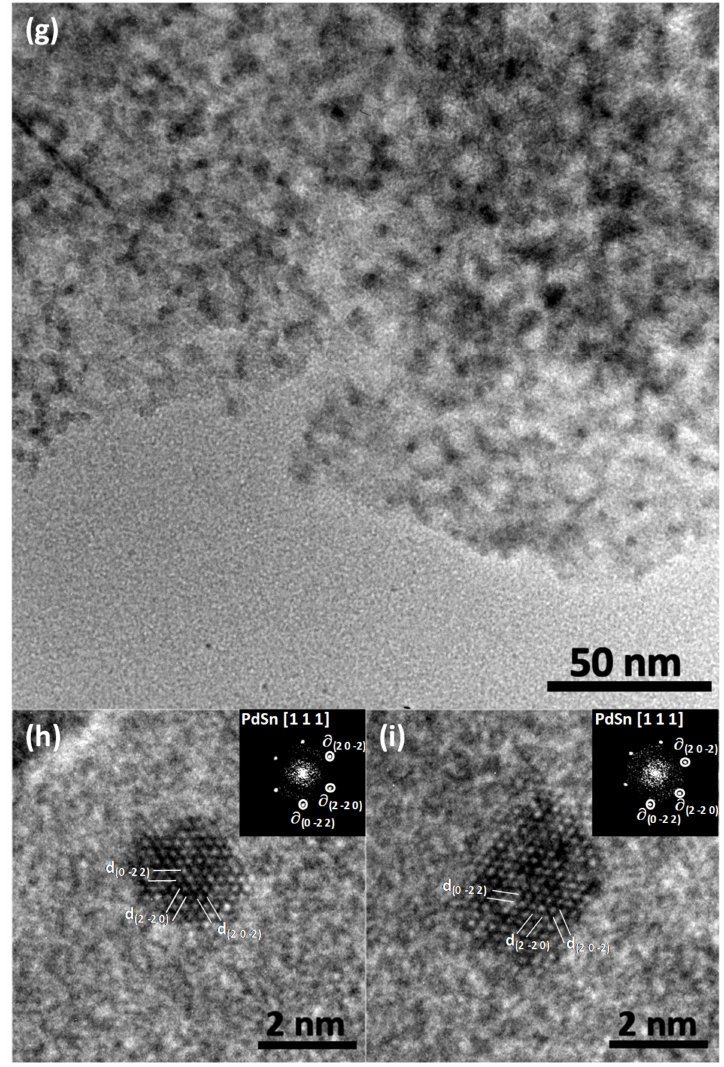
Figure 1. TEM ( a , d , g ) and HRTEM ( b , c , e , f , h , i ) images of the samples Pd/ γ -Al 2 O 3 ( a – c ); 3Pd1Sn/ γ - Al 2 O 3 ( d – f ) and 1Pd1Sn/ γ -Al 2 O 3 ( g – i ). Inserts in the HRTEM images correspond to the 2D-FFTs of the respective nanoparticles; in the inserts ∂ (hkl) correspond to 1/d (hkl)